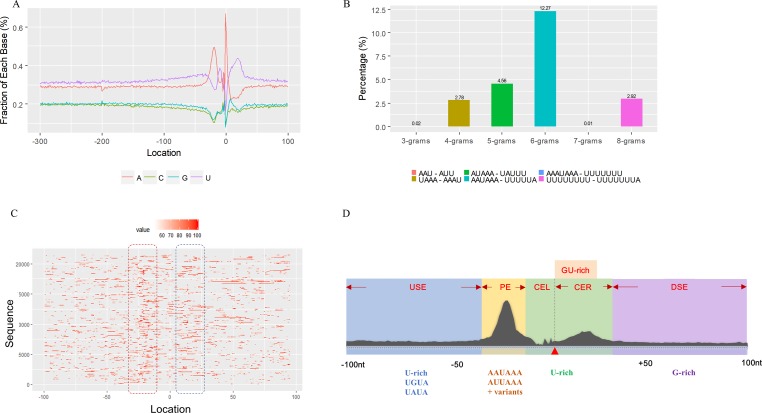
Characteristics of poly(A) signals. (A) Nucleotide profiles surrounding poly(A) sites. (B) The difference of frequency between the highest signal and the second highest signal (displayed in the legend) with different pattern sizes. (C) Top 50 hexamers visual alignment as in the sequence graphics view. Each sequence is present as a single pixel on a horizontal line, and the bright spot represents each occurrence of the signal patterns with respect to their locations on each sequence. The pattern is ranked according to the total frequency that appears in the dataset. The higher the ranking is, the brighter the point is represented. The continuous vertical band of lines from top to bottom indicates the common locations of the signal element. AAUAAA (brightest point) mainly appears around −30 nt to −10 nt (the red dashed box), and the signal aggregation was also observed around +20 nt (the blue dashed box). (D) Schematic of cis elements for poly(A) sites in X. tropicalis. Five regions were determined based on the nucleotide composition profile and the signal analysis. The GU-rich element is overlapped with the downstream U-rich element.